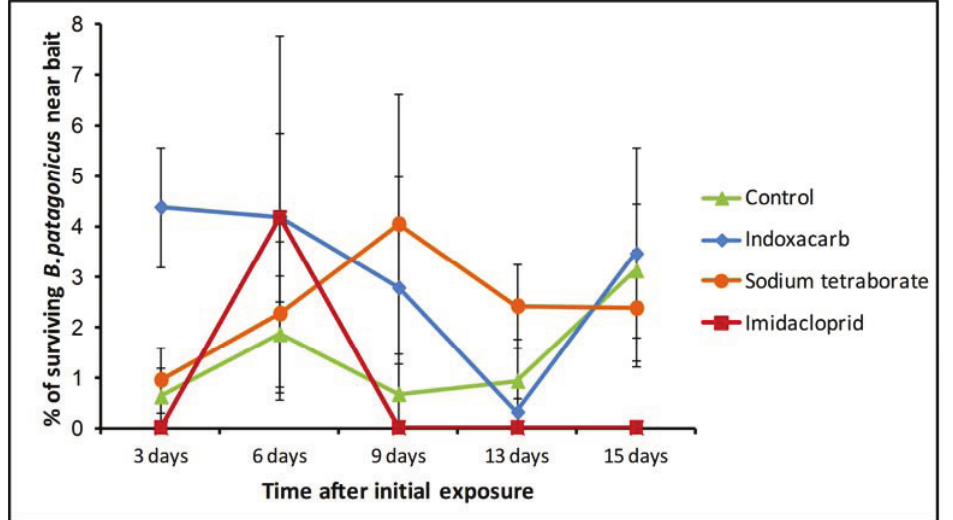
Figure 4. Mean percentage of surviving B. patagonicus found in the Petri dish containing each bait treatment at different times. Error bars were constructed with the standard error of the